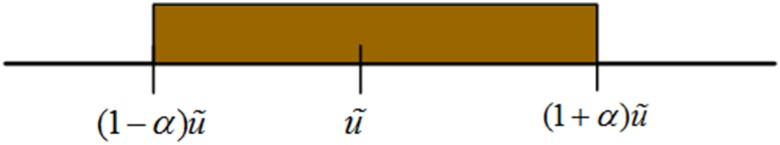
The space of possible values of uncertain variables.